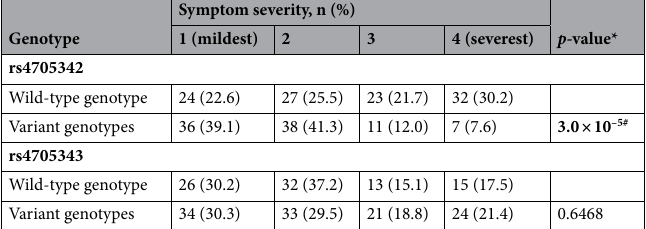
Symptom severity, n